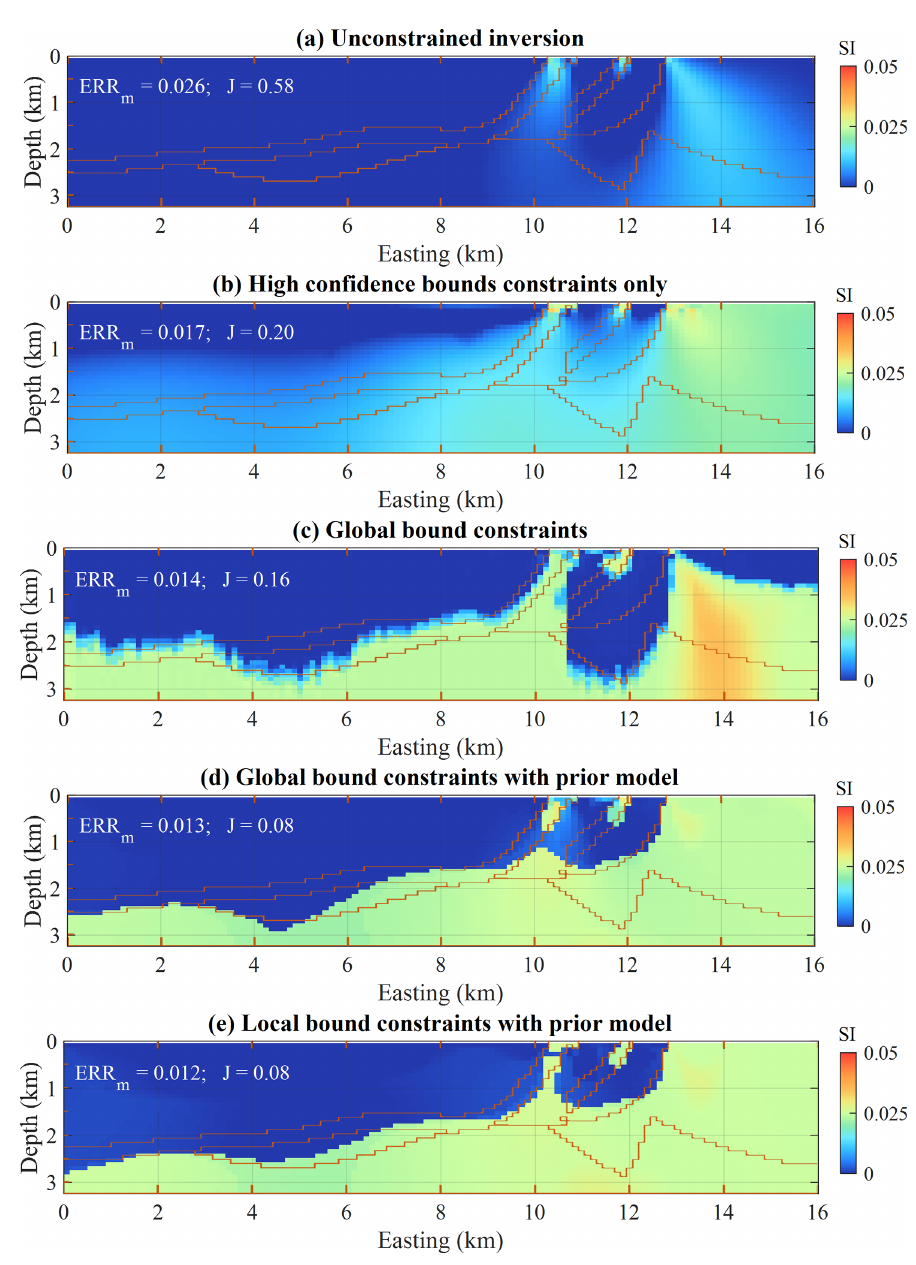
Figure 6. Inversion results for the different scenarios tested. Cases (a) through (e) correspond to inversions using prior information and constraints summarised in Table